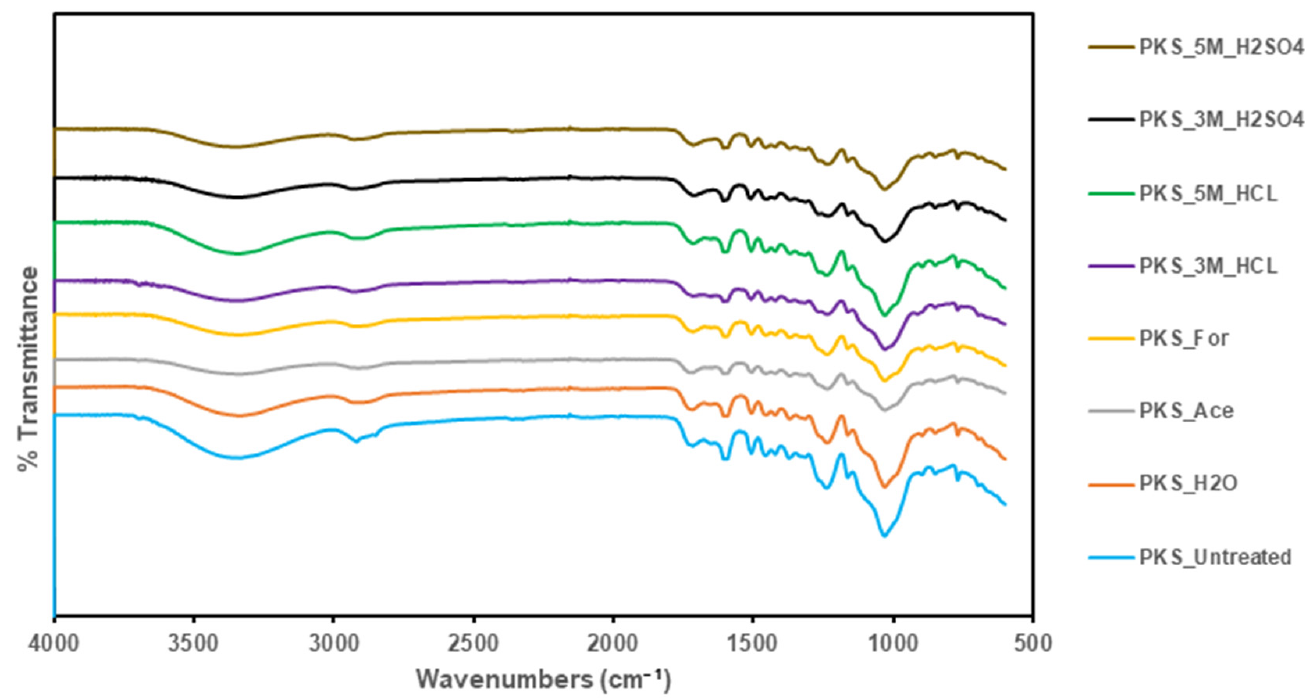
Figure 2. FTIR spectra of the raw and pretreated palm kernel shell.